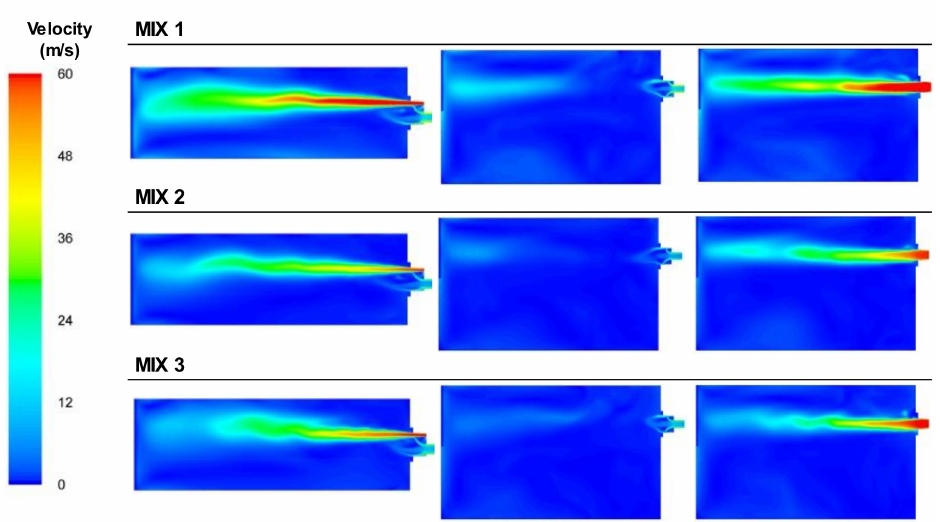
Figure 17. Contour plots of velocities for the BFG/NG mixture cases in the XZ1, XY1, and XY2 planes.